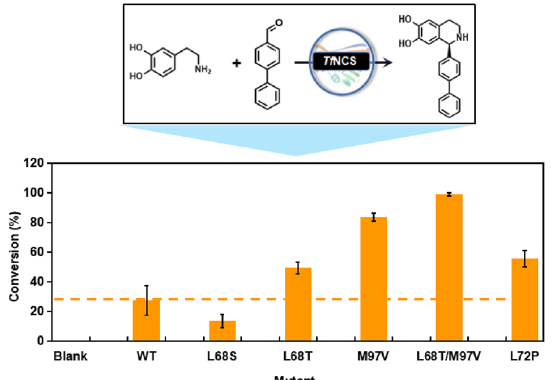
Fig. 6 Biotransformation of 4‑bipenzaldehyde and dopamine catalysed by Tf NCS and its mutants. The reaction mixture was